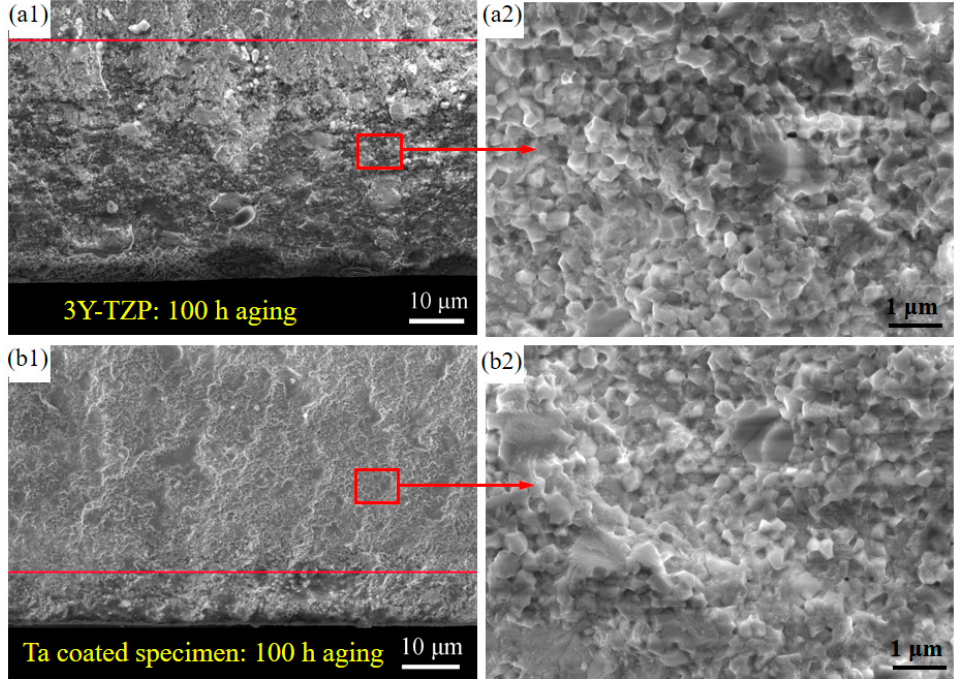
Figure 7. SEM images of fracture surfaces of ( a 1, a 2) uncoated specimens (control) and ( b 1, b 2) Ta-coated specimens after 100 h aging duration. Here, the parts below the red line are the t → m phase transformation region.